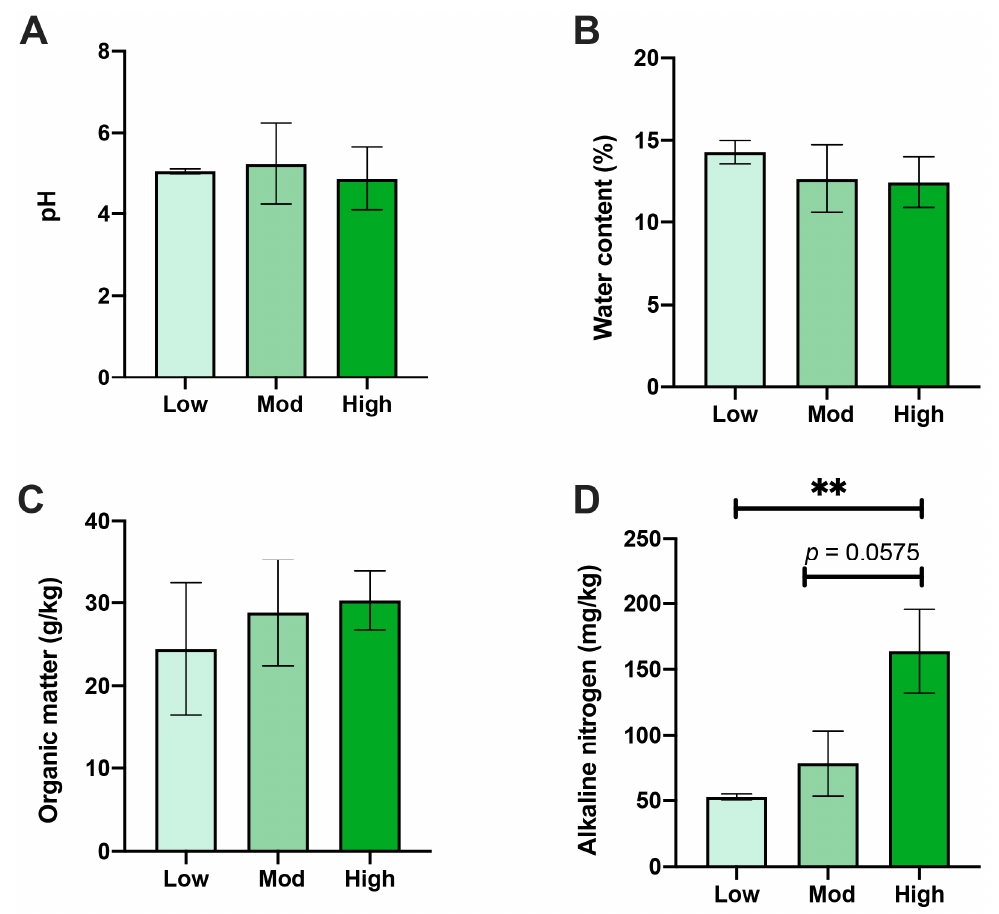
Figure 2. Effects of moso bamboo invasion on rhizospheric soil properties of A. spinulosa. Alterations of ( A ) soil pH, ( B ) water content, ( C ) organic matter, and ( D ) available nitrogen under low, moderate, and high moso bamboo invasions. ** Asterisk indicates the significant difference ( p < 0.01).